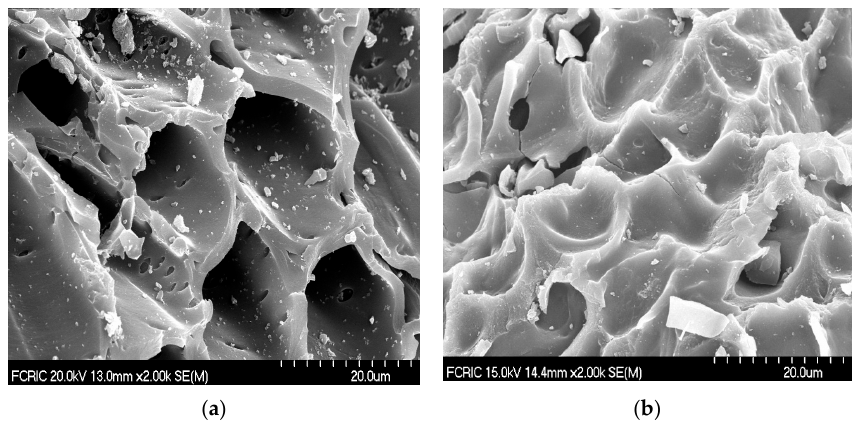
Figure 1. Scanning electron microscope (SEM) micrograph of ( a ) activated carbon (AC) and ( b ) functionalized-AC. ( b )